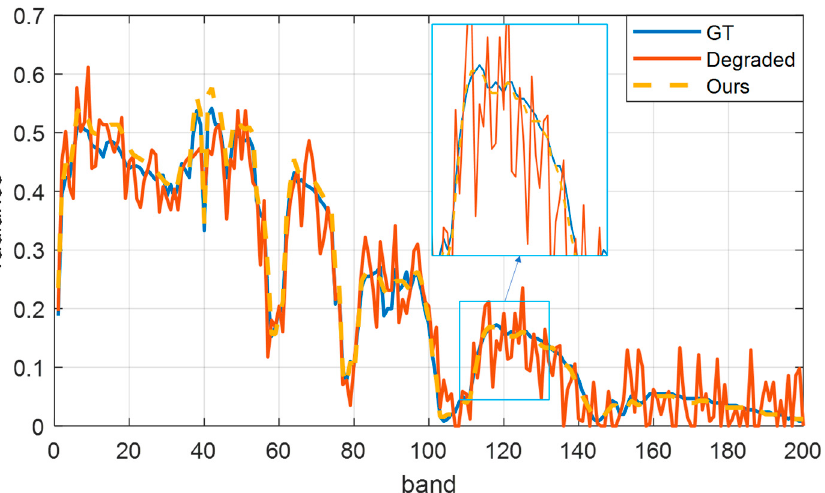
Figure 3. Spectral curve at (40,40) in the Indian Pines dataset. Blue represents the original spectral curve, red represents the spectral curve of degraded data, and yellow represents the spectral curve after quality improvement.